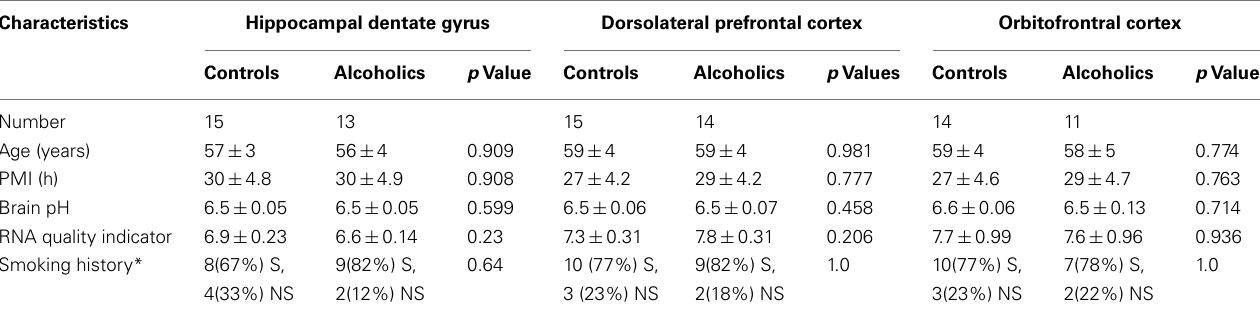
Table 1 | Sample demographic